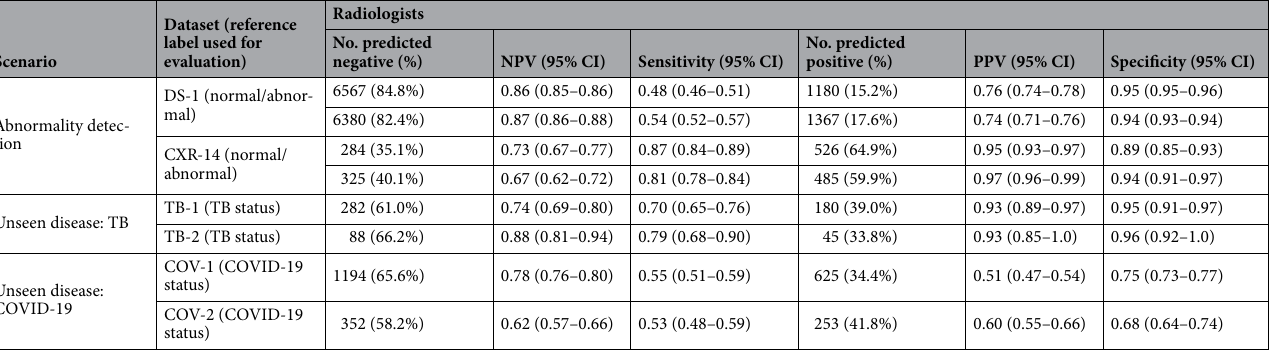
Table 3. Radiologist performance in distinguishing normal and abnormal CXRs across the 6 datasets.